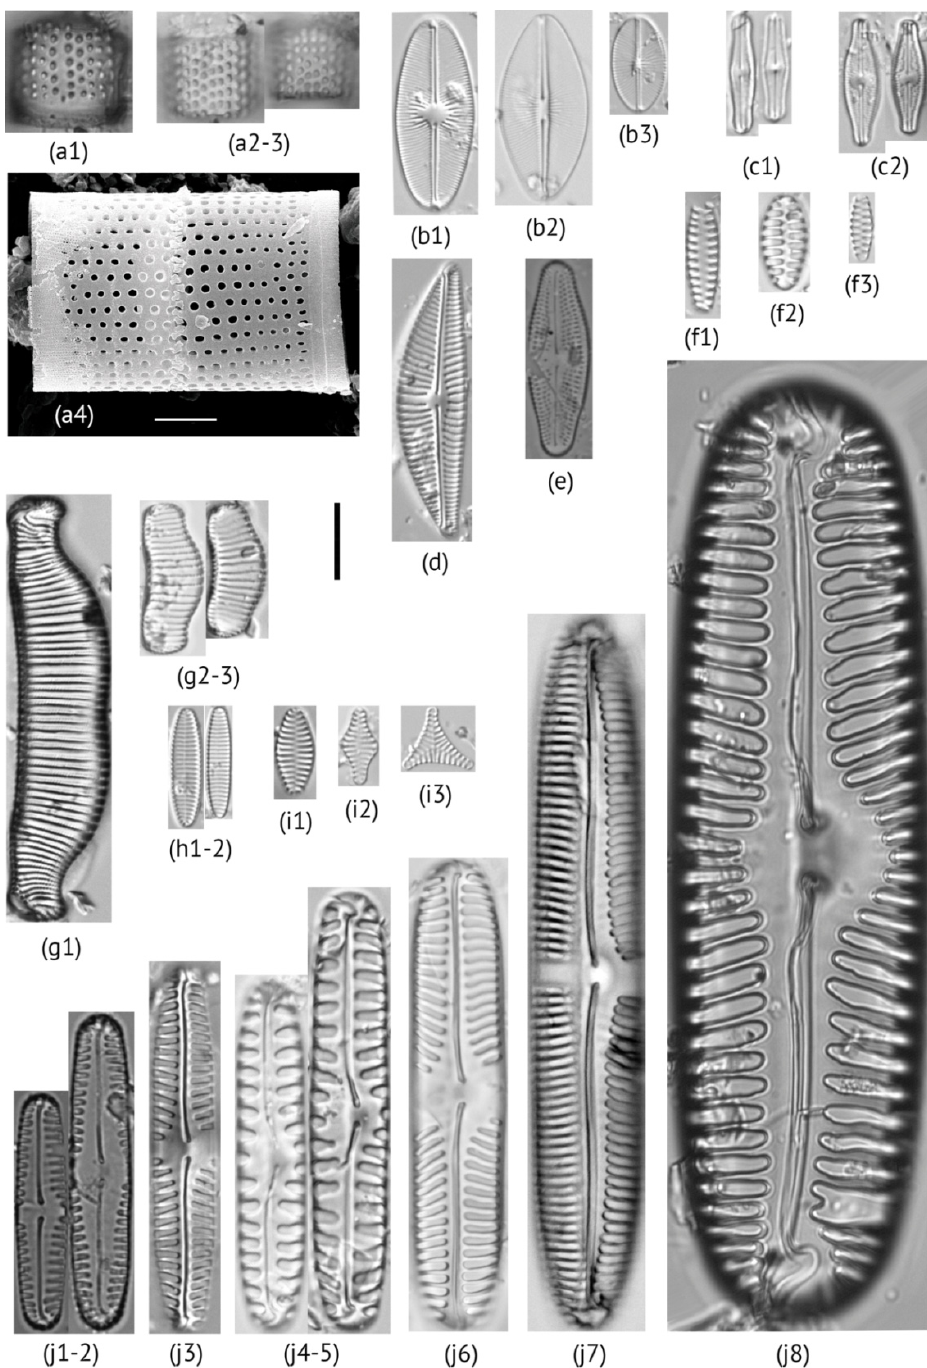
Figure 2. LM and SEM images of dominant species in the peat deposit from McDonald Point, Shemya Island: ( a1 ) Aulacoseira crassipunctata ; ( a2 , 3 ) Aulacoseira canadensis ; ( a4 ) Aulacoseira crassipunctata SEM; ( b1 ) Cavinula davisiae ; ( b2 ) Cavinula cocconeiformis ; ( b3 ) Cavinula cocconeiformis f. elliptica ; ( c1 ) Humidophila laevissima ; ( c2 ) Diadesmis mochalovae ; ( d ) Encyonema silesiacum ; ( e ) Luticola arctica ; ( f1 ) Staurosirella lapponica ; ( f2 ) Staurosirella martyi ; ( f3 ) Staurosirella minuta ; ( g1 ) Eunotia cf. bidens ; ( g2 , 3 ) Eunotia curtagrunowii ; ( h1 , 2 ) Stauroforma exiguiformis ; ( i1 ) Staurosira construens var. venter ; ( i2 ) Staurosira construens ; ( i3 ) Staurosira construens var. exigua ; ( j1 , 2 ) Pinnularia pseudoparva ; ( j3 ) Pinnularia intermedia ; ( j4,5 ) Pinnularia borealis ; ( j6 ) Pinnularia arkadii ; ( j7 ) Pinnularia inconstans ; ( j8 ) Pinnularia lata . Scale bar = 10 µm for all, except ( a4 ). For ( a4 ), scale bar = 5 µm.